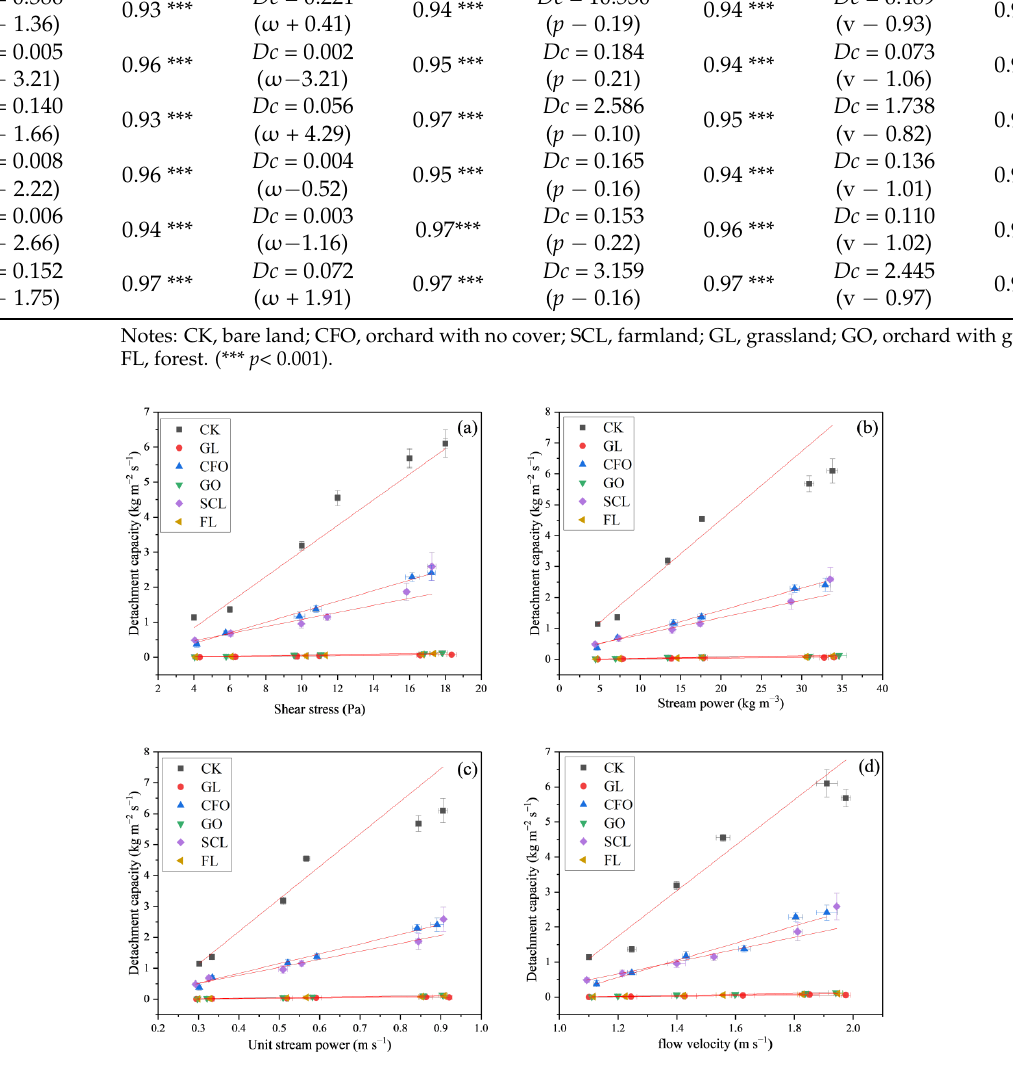
Figure 5. Relationship between soil detachment capacity and shear stress ( a ), stream power ( b ), unit stream power ( c ), flow velocity ( d ). Note: CK, bare land; CFO, orchard with no cover; SCL, farmland; GL, grassland; GO, orchard with grass cover; FL, forest. Table 3. Regression results of soil detachment capacity with shear stress, stream power, unit stream power, and flow velocity under different land use types.